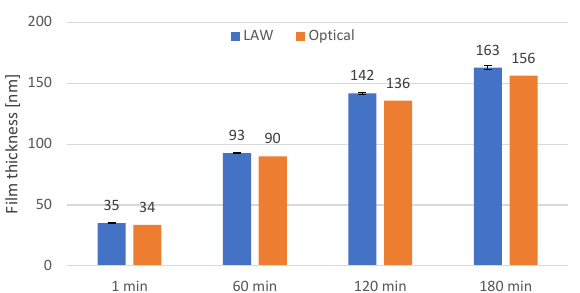
thin films with 2